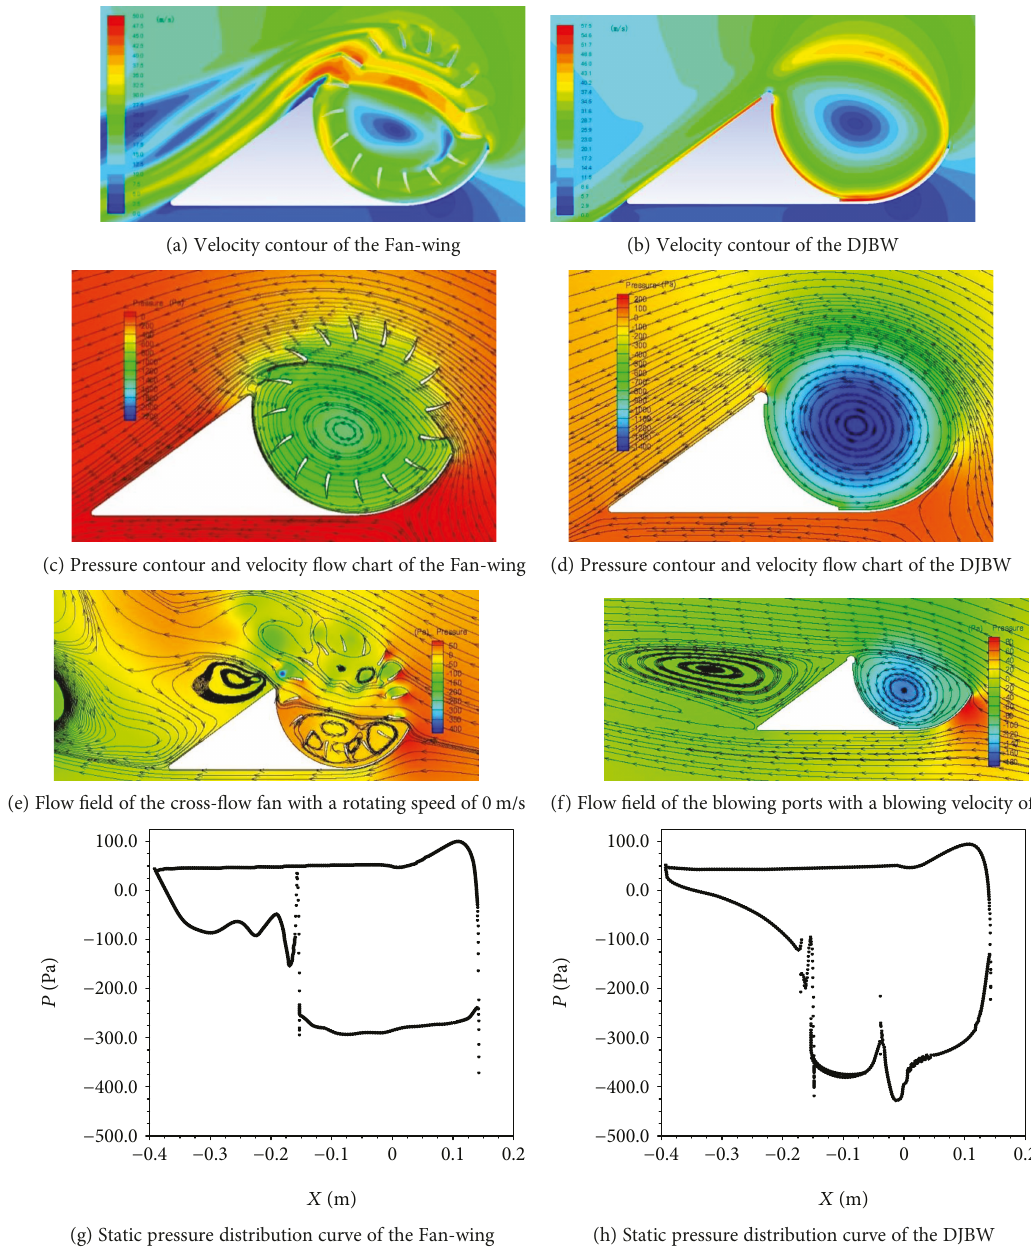
Figure 12: Comparisons of numerical calculation for two